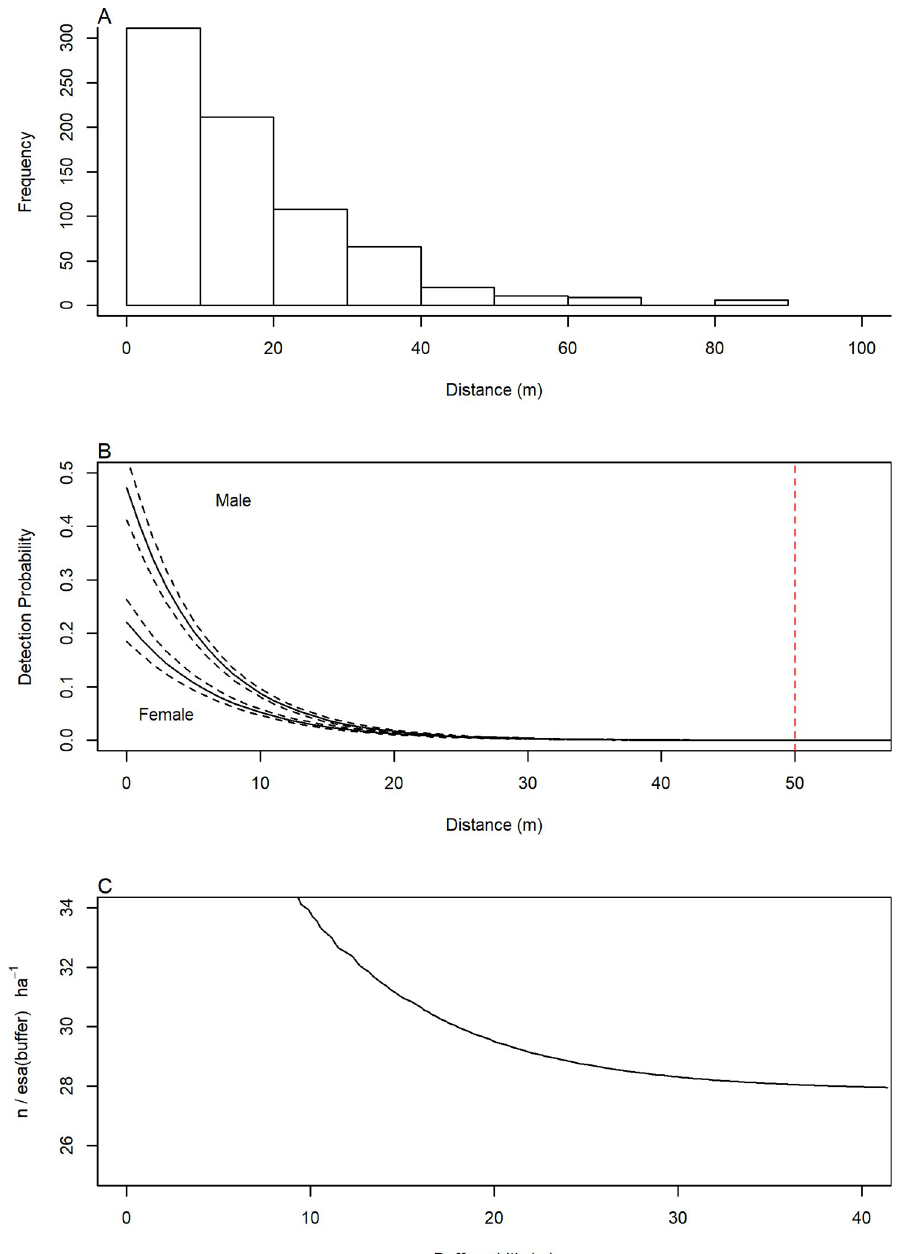
Fig 2. Three indicators inspected to determine the proper buffer distance to implement as well as to determine the correct detection function. A) Salt marsh harvest mouse frequency of distances moved in meters for the entire 18 year full 100 trap dataset; B) Detection probability curves for male and female SMHM related to distance (red line indicates buffer distance used); C) Effective sampling area as a function of increasing buffer